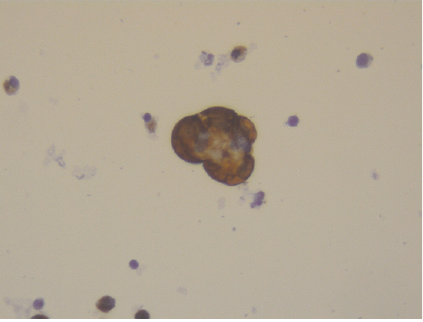
Figure 10: Immunostain for Ker5/6: keratin granuloma with posi- tive expression in peritoneal